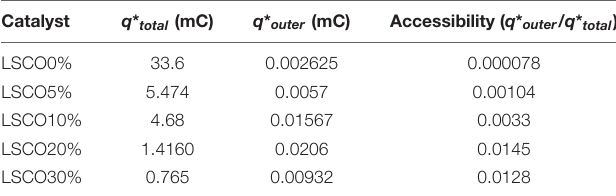
TABLE 3 | Comparison between the total charge, outer charge, and charge accessibility of the LSCO0%, LSCO5%, LSCO10%, LSCO20%, and LSCO30%